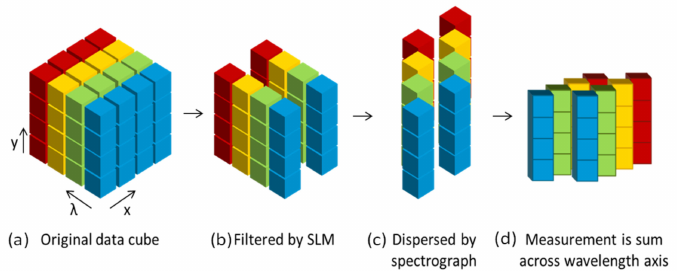
Figure 2. Illustration of the content of the image as seen by CA multiplexed sensor as depicted in Figure 1. ( a ) The hyperspectral data cube which consists of two spatial dimensions of x and y, and one spectral dimension, λ . ( b ) It is then filtered by a code in the undispersed plane such that selected signals at particular spatial locations are allowed to pass through. ( c ) The optical signal is then dispersed and ( d ) reimaged onto a detector, which senses the sum of all optical signals of voxels across the wavelength dimension [2].